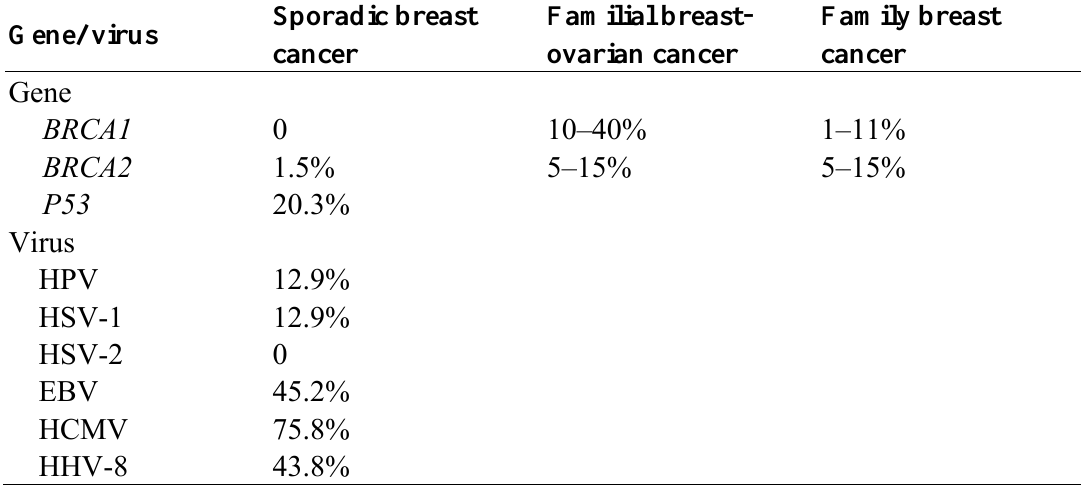
Table 1. Gene mutations/virus presentation in breast